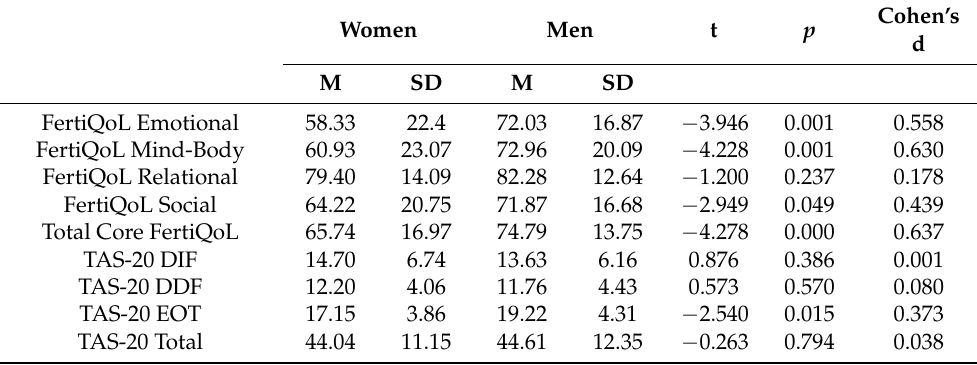
Table 1. Differences in Fertility Quality of Life and alexithymia between the couple’s members.